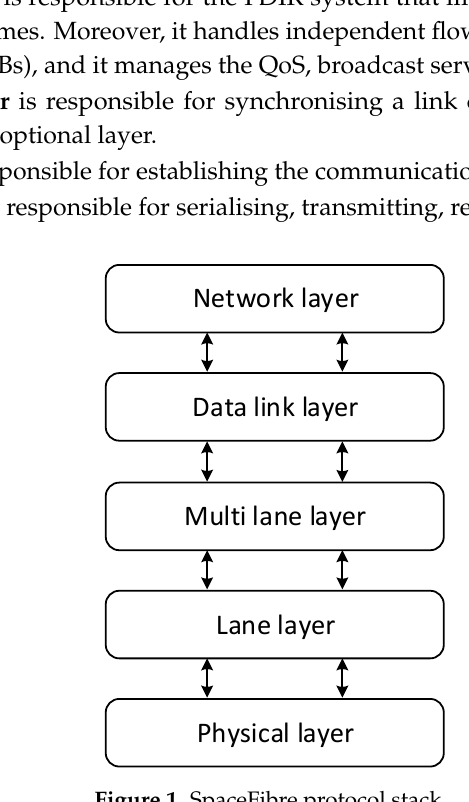
Figure 1. SpaceFibre protocol